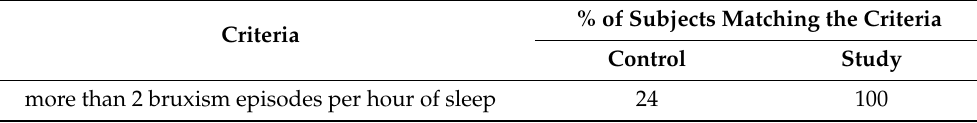
Table 11. The cut-o ff criteria for bruxism evaluated in the study group and in the control group using the Bruxo ff